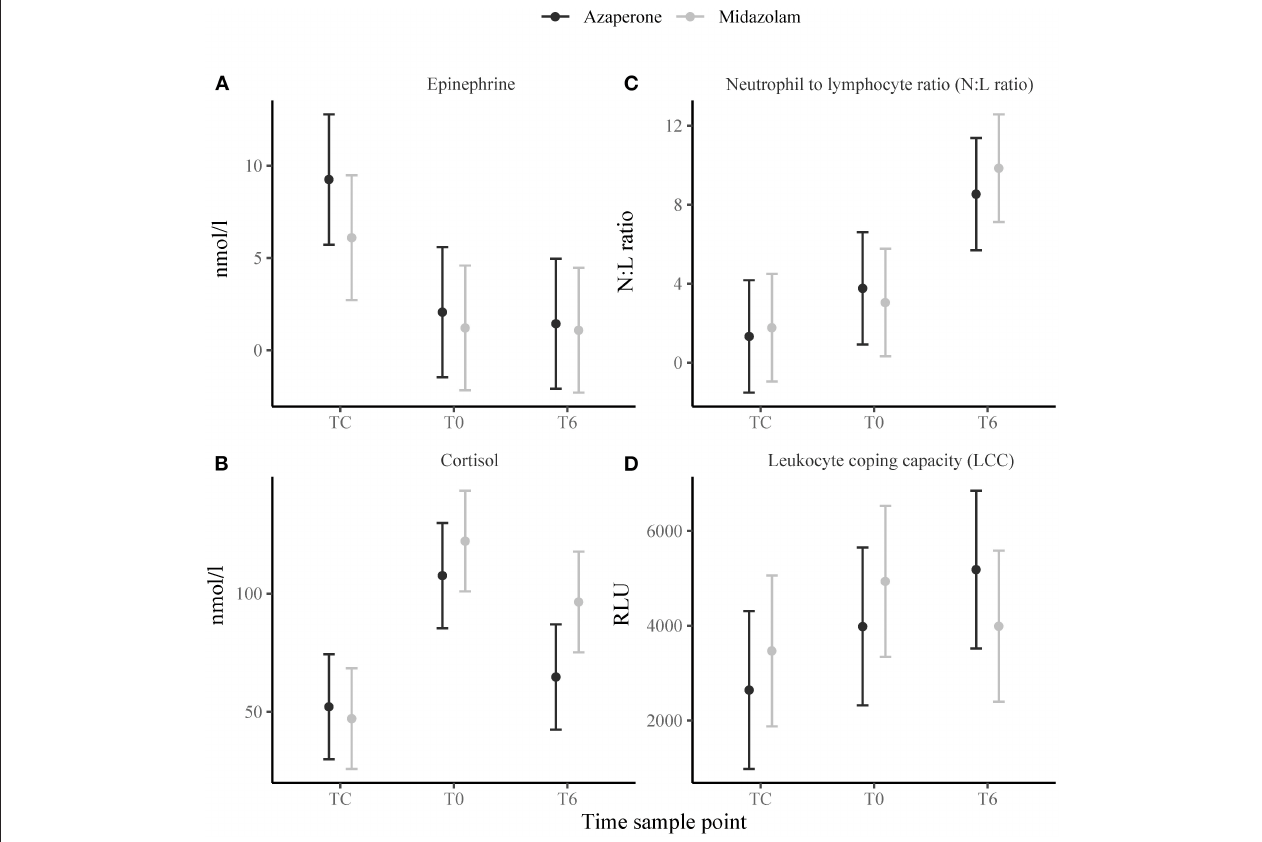
FIGURE 2 | Means ± standard error of stress response indicators: (A) epinephrine, (B) cortisol, (C) neutrophil to lymphocyte ratio (N:L ratio), (D) leukocyte coping capacity (LCC) in white rhinoceroses captured and transported with either azaperone or midazolam. Time sample points: capture (TC), start of transport (T0), and 6 (T6) h of